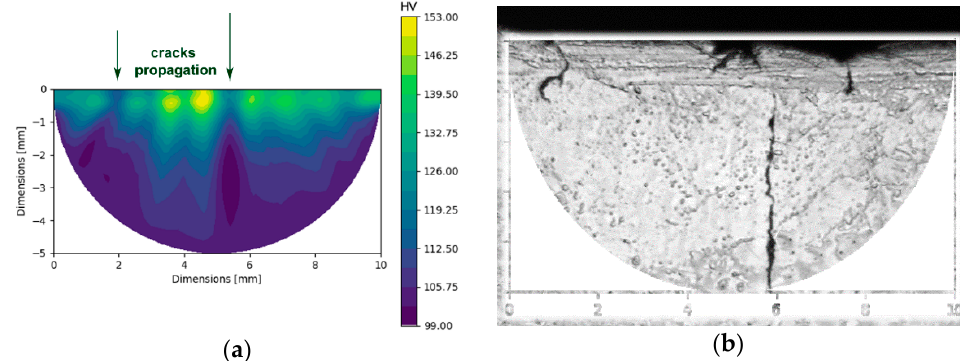
Figure 7. Map of experimentally measured microhardness in the cracked area ( a ); the correspond- ing cracked location, with depiction of the mapped area ( b ).